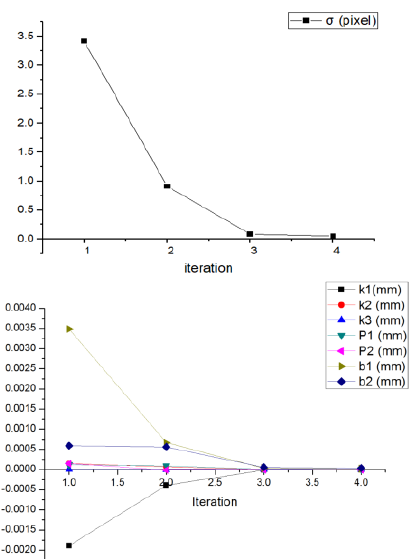
Figure 5. Changes of σ and planimetric distortion coefficients of Trial B .